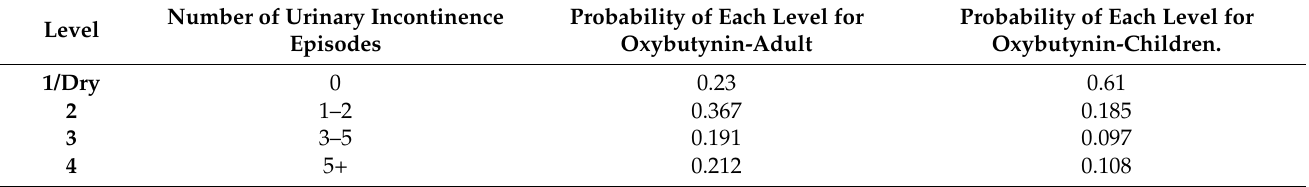
Table A8. Sensitivity Analysis Utility Change For Paediatric OAB.